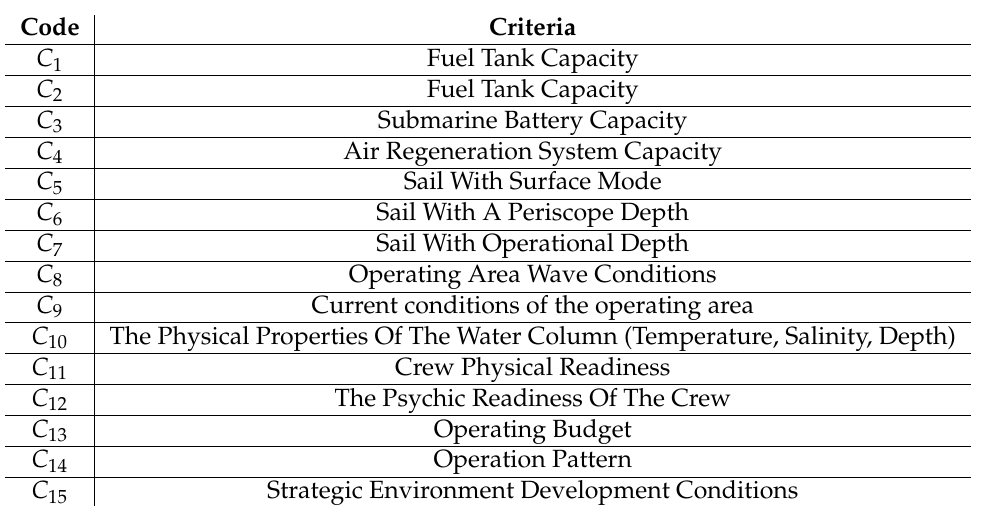
Table 4. Elements of Ketahanlamaan Operasional Kapal Selam